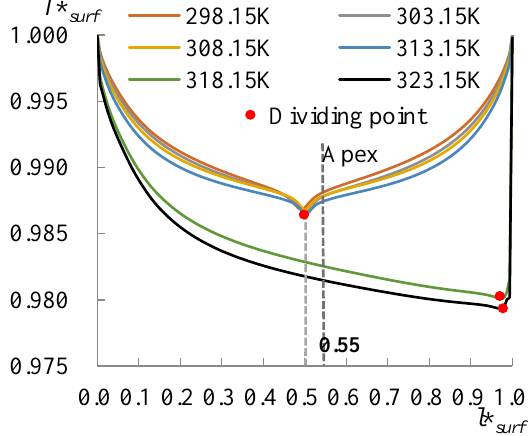
Figure 8. Temperature at the LA interface. For T s ≤ 313.15 K, the lowest surface temperature (dividing point) lies near the middle position rather than on the apex of the non-spherical droplet, and when T s = 318.15 K and 323.15 K, the lowest temperature moves to the rightmost side of the droplet.